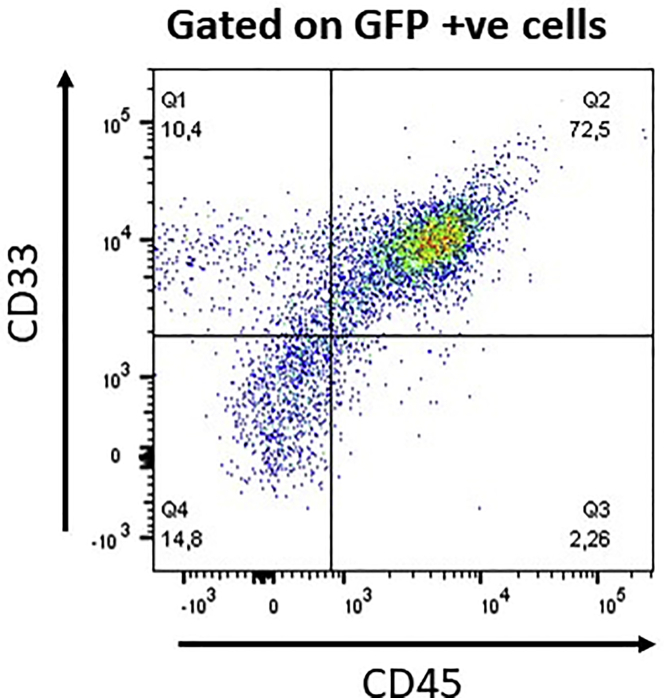
Identification of Transduced Cells In VivoFlow cytometric analysis of transduced primary AML cells isolated from the femur of a mouse.